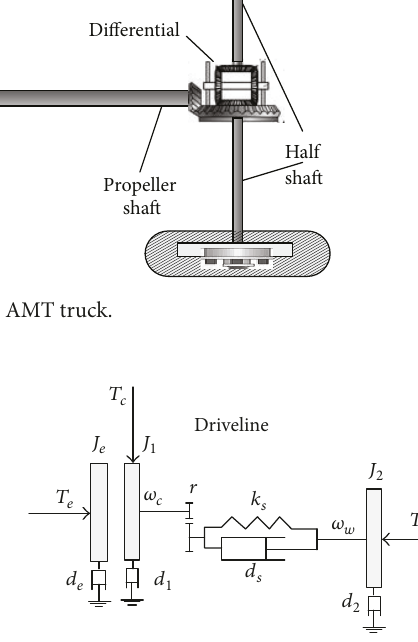
Figure 2: Simplified model of the